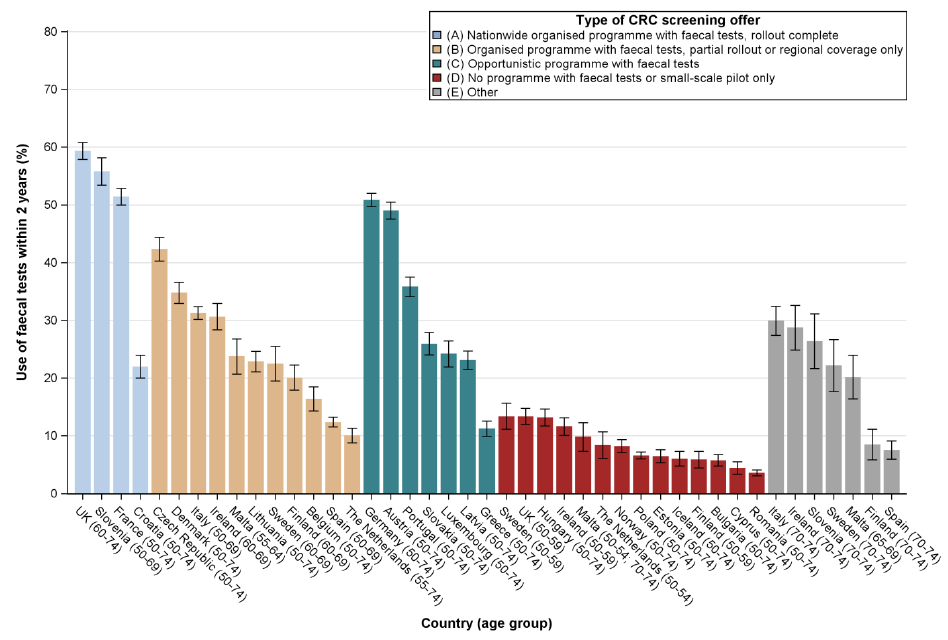
Figure 1. Prevalence estimates of faecal test use within the previous 2 years among the general population aged 50–74 years in all EU countries, Iceland, Norway and the UK, by type of screening offer (data: EHIS, 2013-2016).